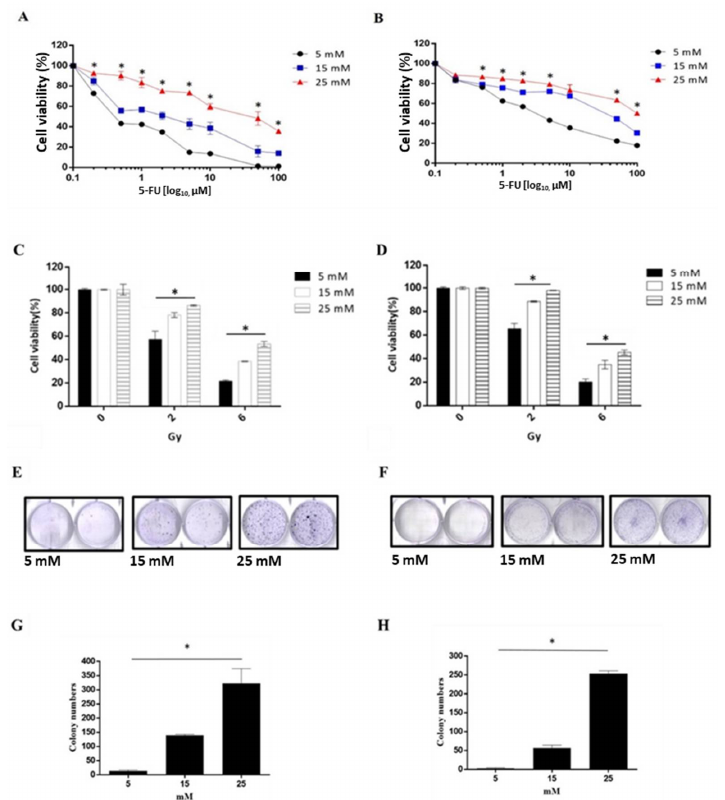
Figure 3. Effects of high glucose on chemoresistance and radioresistance in rectal cancers. HCT116 ( A ) and SW480 ( B ) cells were treated with serial dilution of 5-FU in different glucose concentrations for 48 h and analyzed by measuring relative luminescence units (RLU). HCT116 ( C ) and SW480 ( D ) cells were exposed to 0, 2, or 6 Gy in 5, 15, or 25 mM glucose concentrations for 48 h. The cell viability was calculated by measuring RLU. In the colony formation analysis, HCT116 ( E ) and SW480 ( F ) cells were cultured in the media with 5, 15, or 25 mM glucose concentration exposed to 2 Gy. After 2 weeks, cells were stained and colony formation was calculated. The colony numbers were evaluated ( G , H ). Cell viability (%) = (abs sample − abs blank)/(abs control − abs blank) × 100. Data are presented as mean ± SD ( n = 3; * p <